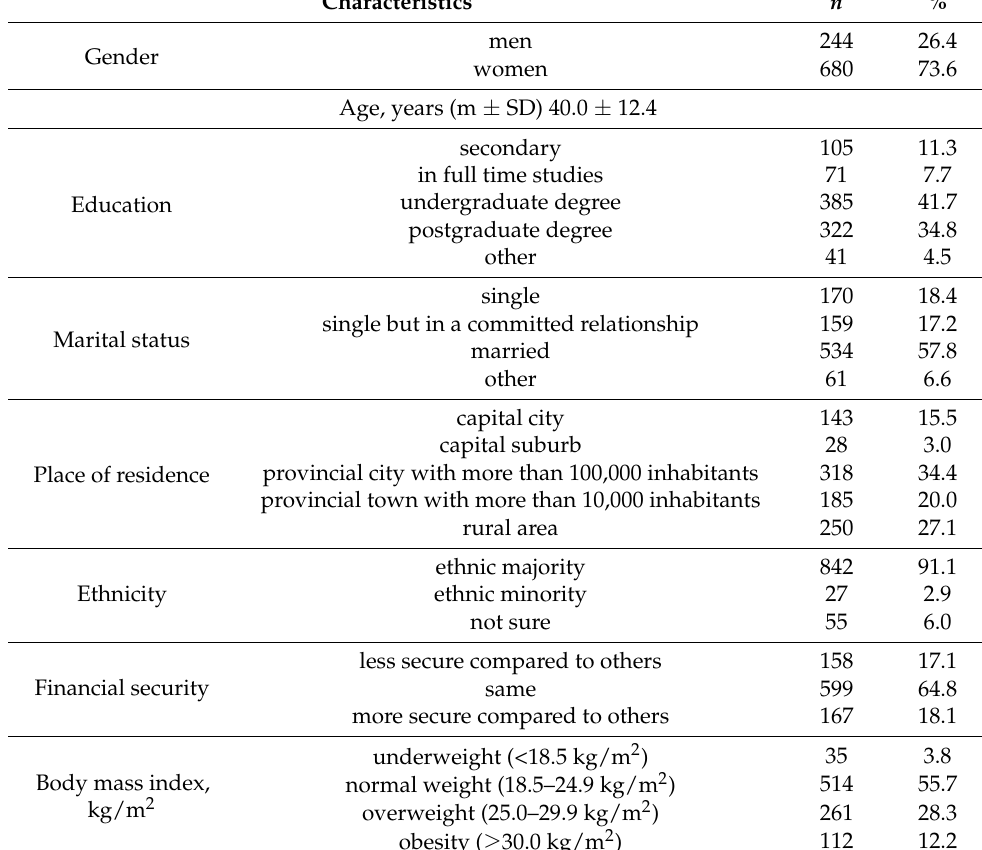
Table 1. Sample characteristics ( n =